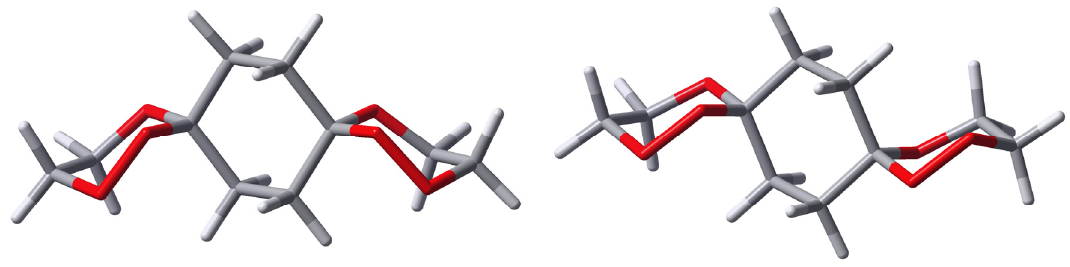
Figure 3 . Calculated structures of two distinct conformers (left: equilateral, right: antilateral) of syn - 9 .